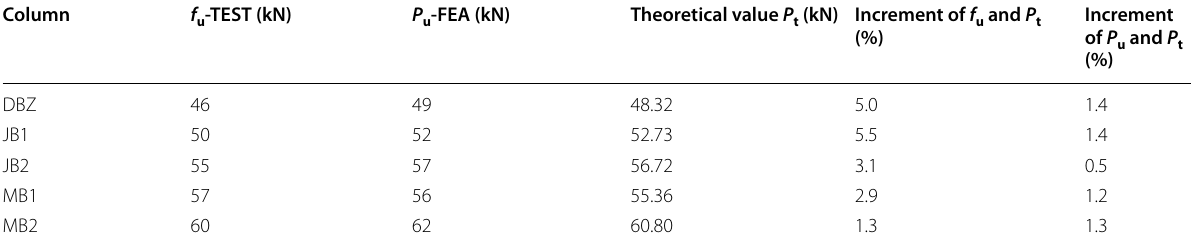
P u is ultimate load of FEA; f u is ultimate load of test